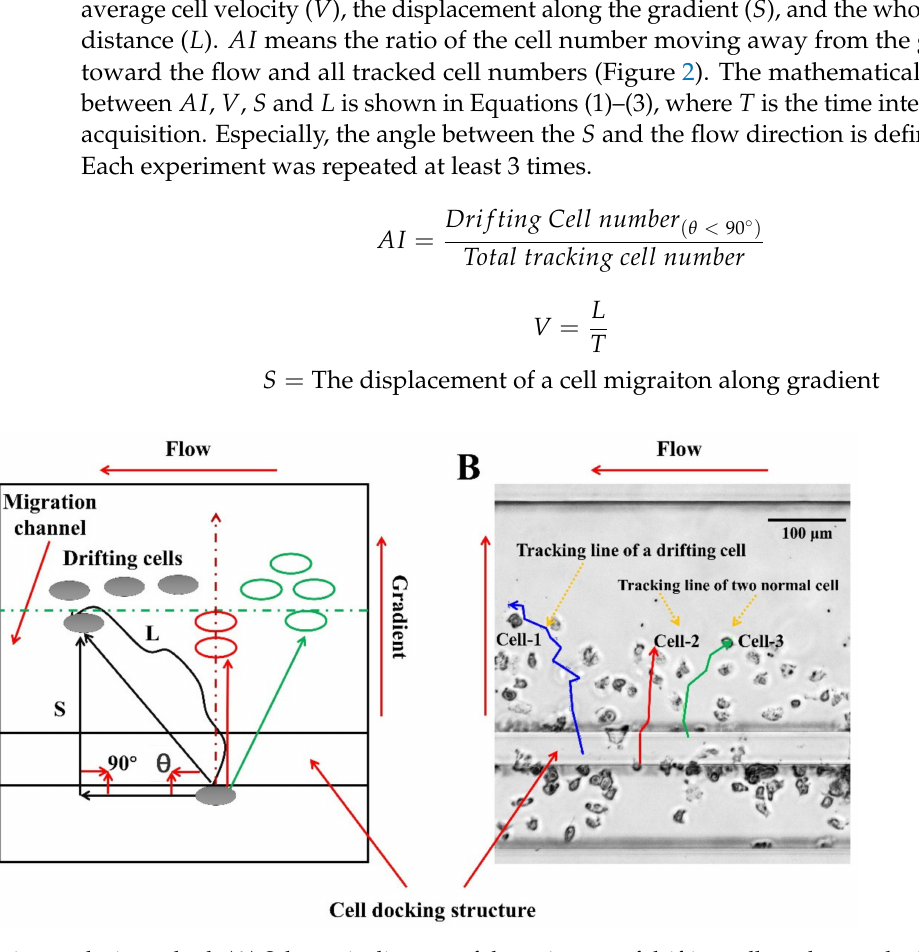
Figure 2. Cell migration analysis method. ( A ) Schematic diagram of the trajectory of drifting cells and normal cells. If θ is less than 90 degrees, the cells are migrating along with the flow. If θ is greater than 90 degrees, the cell migration progress is less affected by the flow. ( B ) The real trajectory of the drifting cells and normal cells in the cell migration